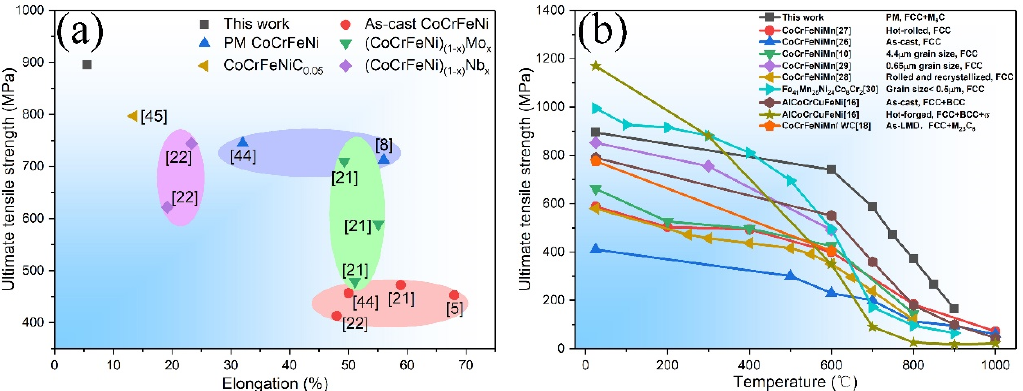
Figure 6. ( a ) Room-temperature tensile properties and ( b ) temperature dependence of the UTS of the HEA in this work and other FCC-based HEAs reported in